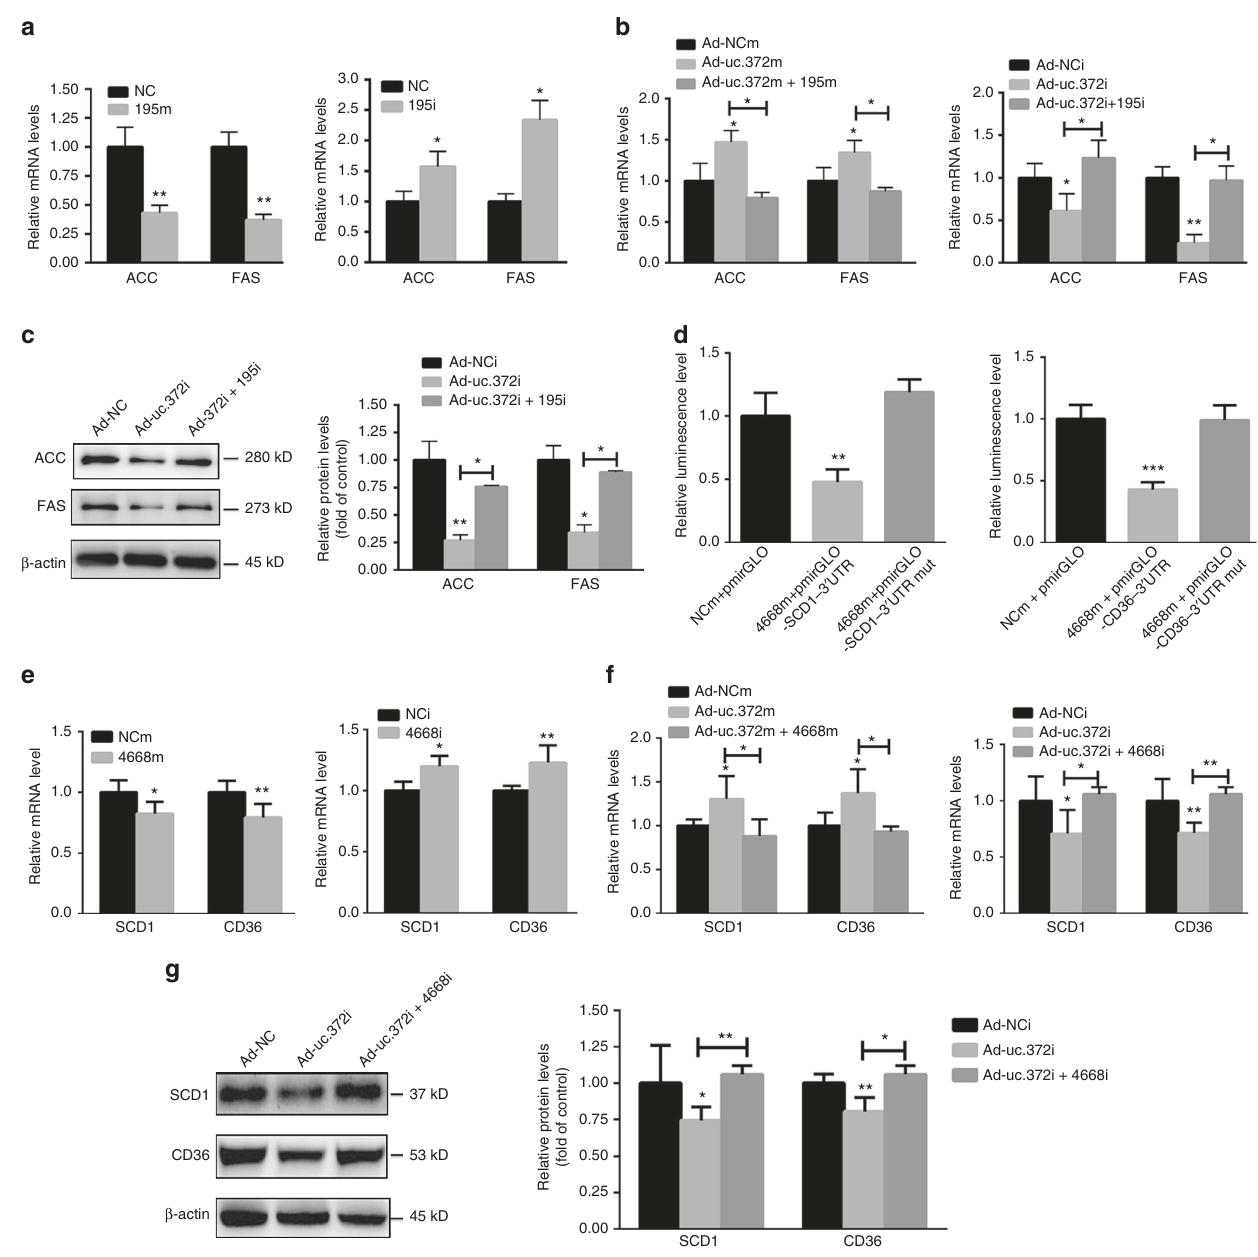
Fig. 5 uc.372 inhibits the maturation of miR-195/miR-4668 to regulate expression of ACC, FAS, SCD1, and CD36. a Expression levels of ACC and FAS in the HepG2 cells transfected with miR-195 mimic and inhibitor at a fi nal concentration of 20 nM for 48 h ( n = 3). b Expression levels of ACC and FAS in the HepG2 cells transfected with miR-195 mimic and inhibitor for 24 h in the presence with Ad-uc.372m and Ad-uc.372i ( n = 3). c Protein levels of ACC and FAS in Ad-uc.372i-infected and miR-195 inhibitor-transfected HepG2 cells in the presence with with 300 μ M O/P mixture for 48 h (representative blots from three similar experiments) ( n = 3). d The relative luciferase units (RLU) in the HepG2 cells transfected with pmirGLO-SCD1-3 ′ UTR and pmirGLO- SCD1-3 ′ UTR mutant or pmirGLO-CD36-3 ′ UTR and pmirGLO-CD36-3 ′ UTR mutant under overexpression of miR-4668 or NC for 48 h ( n = 3). e Expression levels of SCD1 and CD36 in the HepG2 cells transfected with miR-4668 mimic and inhibitor or NC for 48 h ( n = 3). f Expression levels of SCD1 and CD36 in the HepG2 cells transfected with miR-4668 mimic and inhibitor for 24 h in the presence with Ad-uc.372m and Ad-uc.372i ( n = 3). g Protein levels of ACC and FAS in Ad-uc.372i-infected and miR-4668 inhibitor-transfected HepG2 cells in the presence with 300 μ M O/P mixture for 48 h (representative blots from three similar experiments) ( n = 3). Data are mean ± SEM; * P < 0.05; ** P < 0.01; *** P < 0.001 vs. control group ( a , e Student ’ s t -test; b , c , d , f , g analysis of variance